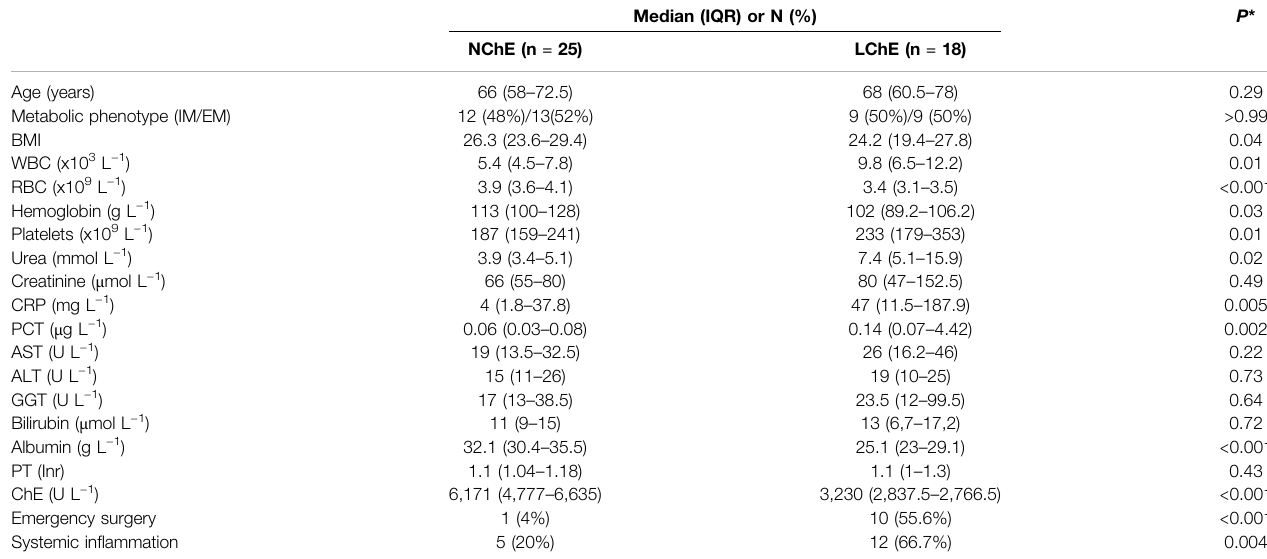
TABLE 4 | A comparison of patient characteristics according to preoperative cholinesterase activity. Data are presented as median (interquartile range), or (N) and ratio (%). WBC, white blood cells; RBC, red blood cells; CRP, c-reactive protein; PCT, procalcitonin; AST, aspartate aminotransferase; ALT, alanine aminotransferase; GGT, gamma-glutamyltransferase; PT, prothrombin time; ChE, cholinesterase; NChE, ChE > 4244 U L − 1 ; LChE, ChE ≤ 4244 U L − 1 . *Mann-Whitney U test for continuous, and Fisher ’ s exact test for categorical variables.